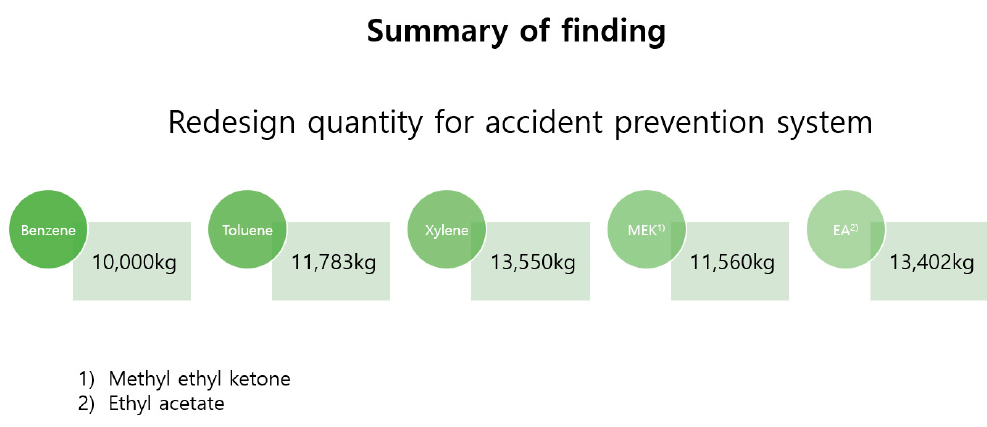
Figure 3. Summary of findings.